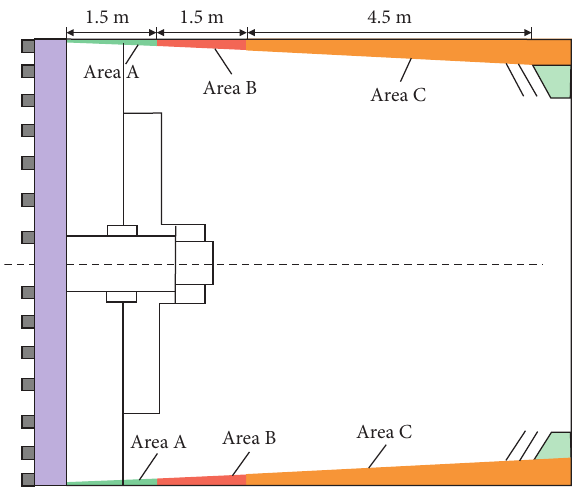
Figure 29: Shield excavation gap filling